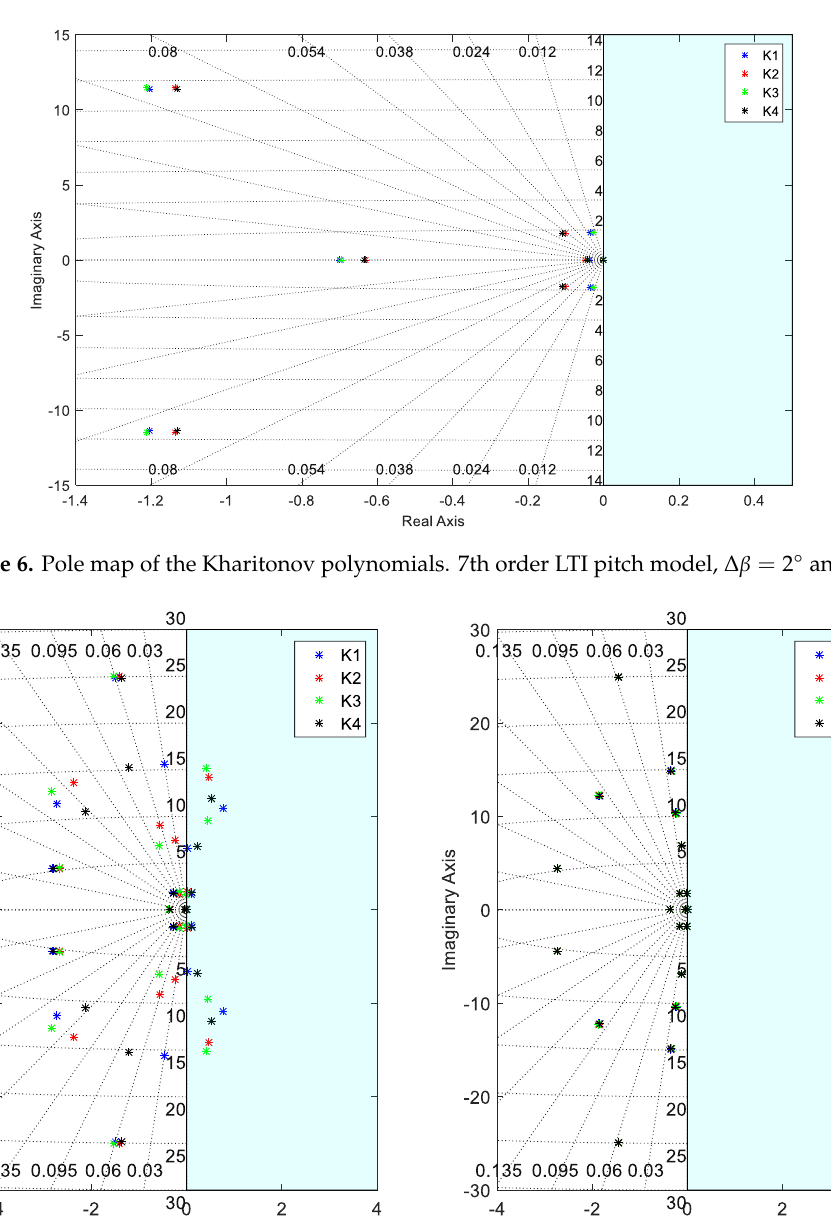
Figure 7. Pole map of the Kharitonov polynomials. 19th order LTI pitch model, ∆𝜷 = 𝟐° and ( a ) 𝒒 𝟐 ( b ) 𝒒 𝟓 .